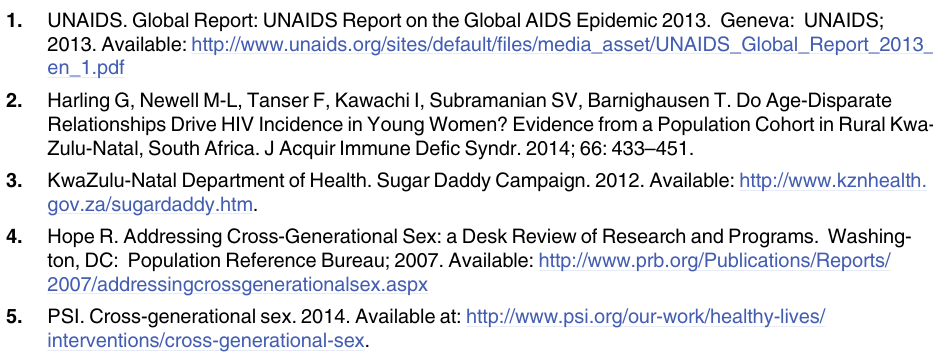
S9 Table. Multivariable logistic regression models of inconsistent condom use reported by men in partnerships with 16 to 24 year old women. S10 Table. Multivariable logistic regression models of sexual behaviours within partner- ships reported by 16 to 24 year old women (independent variable = years age difference). S11 Table. Multivariable logistic regression models of sexual behaviours reported by men in partnerships with 16 to 24 year old women (independent variable = years age